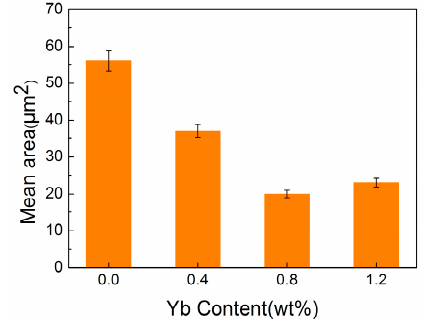
Figure 6. Mean area of the iron-rich phases with different Yb additions.